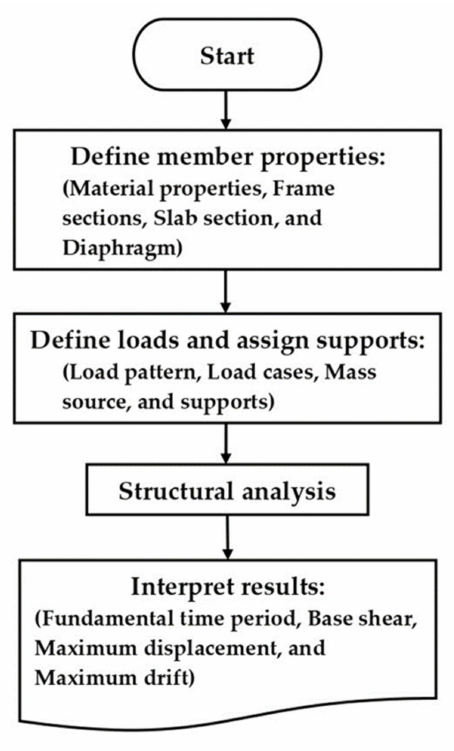
Figure 2. Flowchart of the modeling procedures using